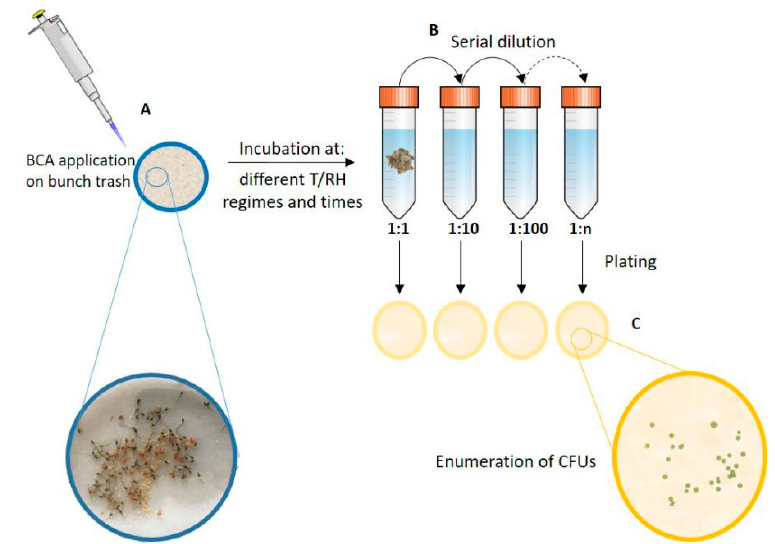
Figure 1. Bunch-trash aliquots were arranged in Petri plates (one aliquot per plate) over a wet